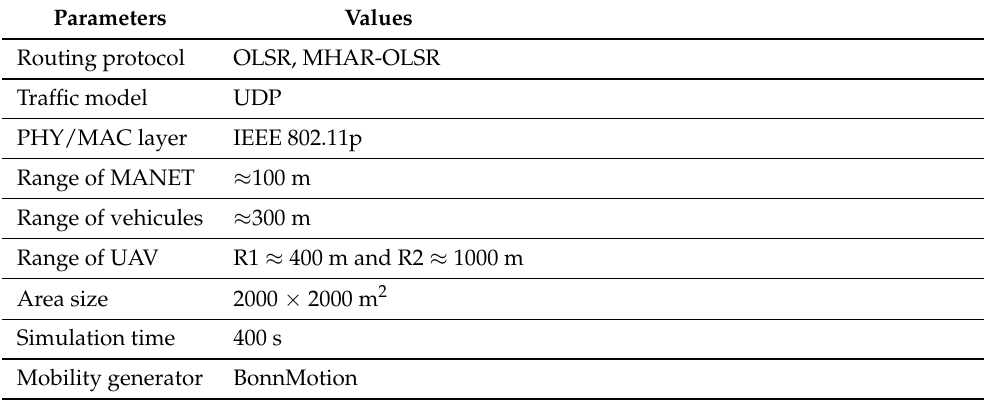
Table 2. Simulation